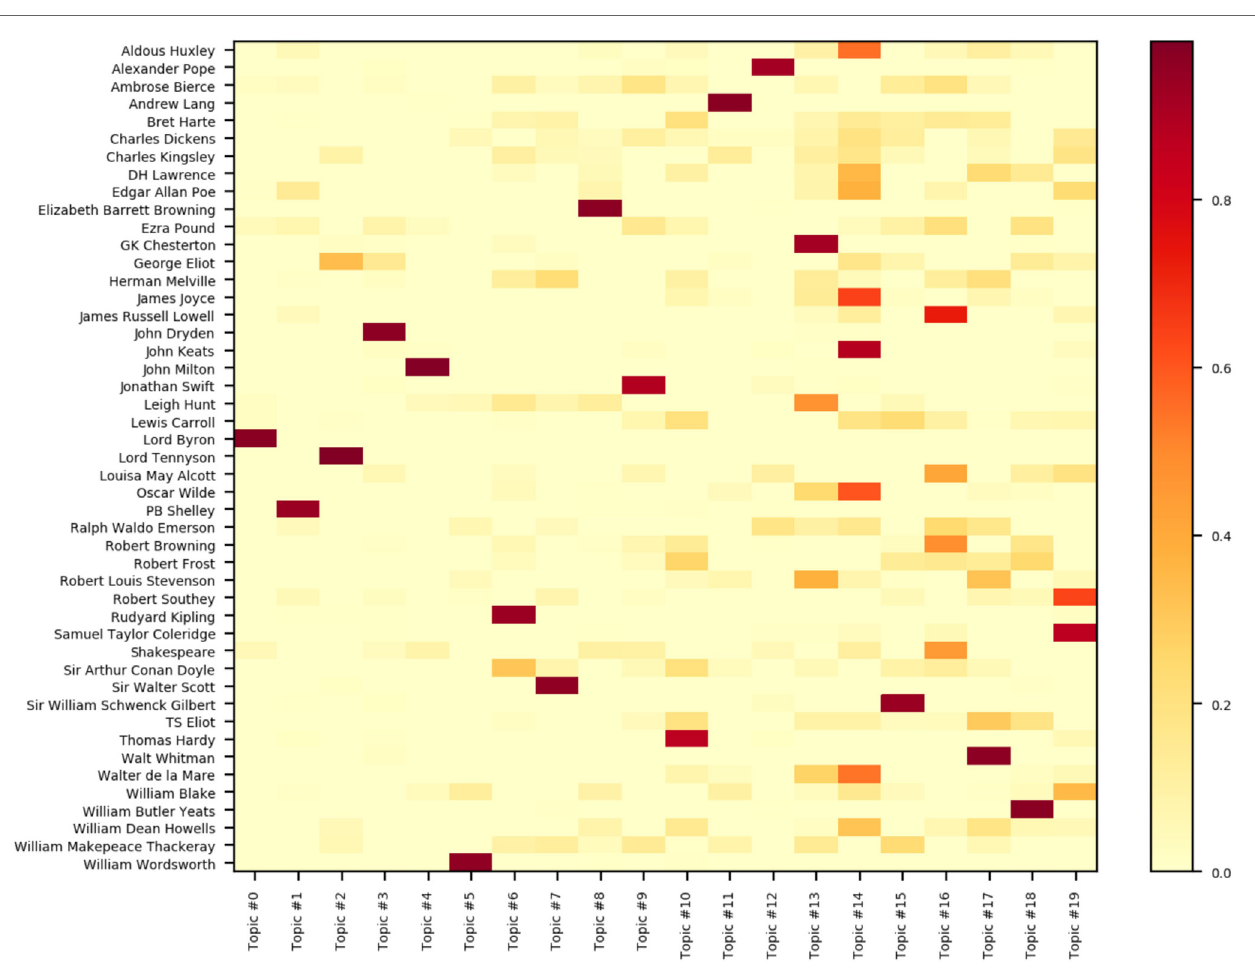
FigUre 2 | Heat map of 20 main topics for the 47 texts of the Gutenberg English Poetry Corpus based on Non-Negative Matrix Factorization.